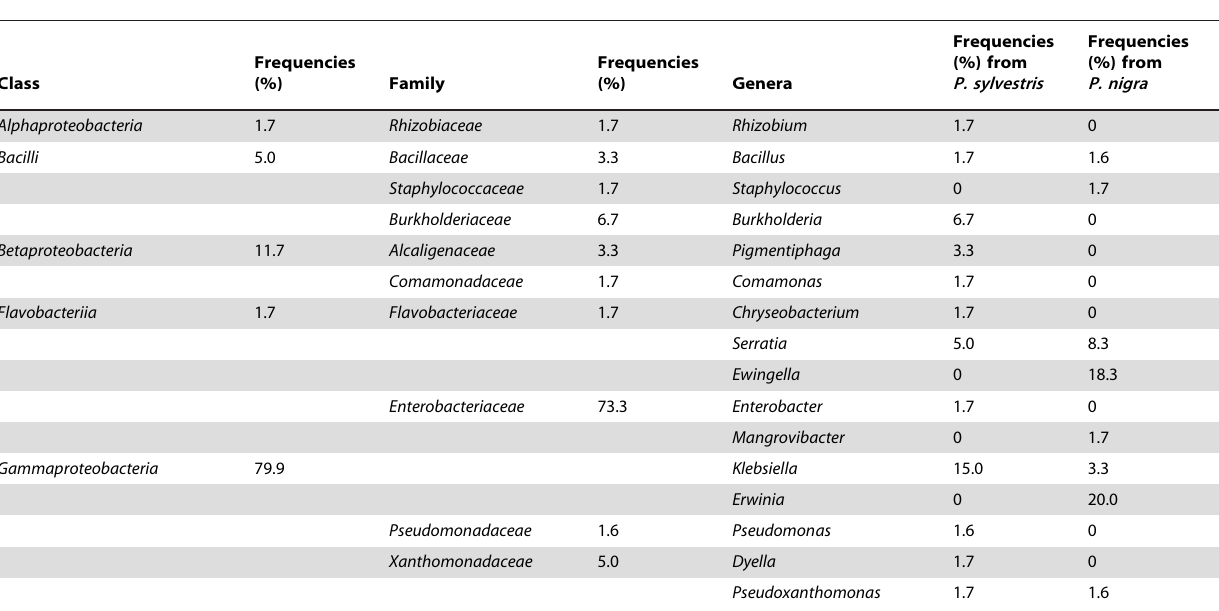
Table 2. Frequencies of bacterial taxa carried by B. xylophilus isolated from different Pinus spp.